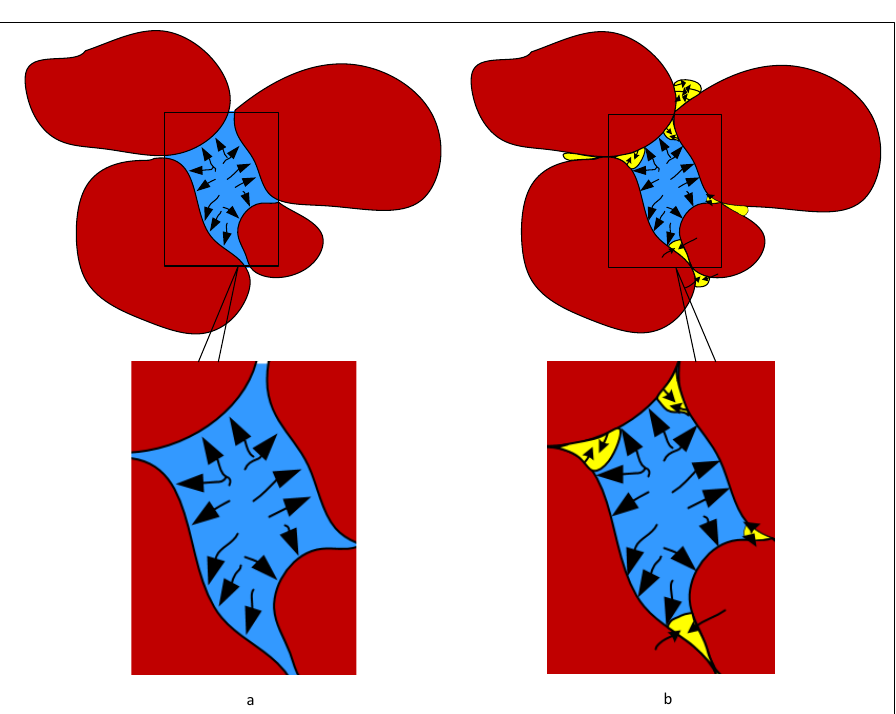
Figure 5. Representation of pore pressure in soil void: ( a ) Pore pressure developed by pore water pushing soil grains away from each other, leading to the loosening of the soil mass. ( b ) Cementation of soil grains by bioprecipitated calcite offering resistance to pore pressure.